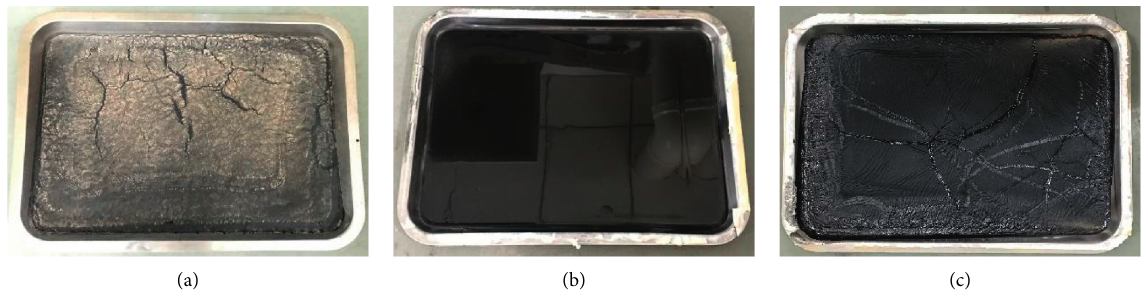
Figure 3: The asphalt binder sample after natural aging. (a) All; (b) TO; (c)